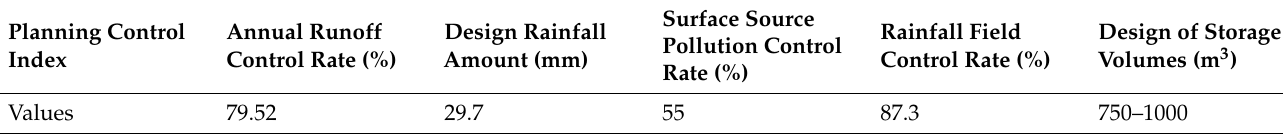
Table 5. Study area sponge city design scale and control